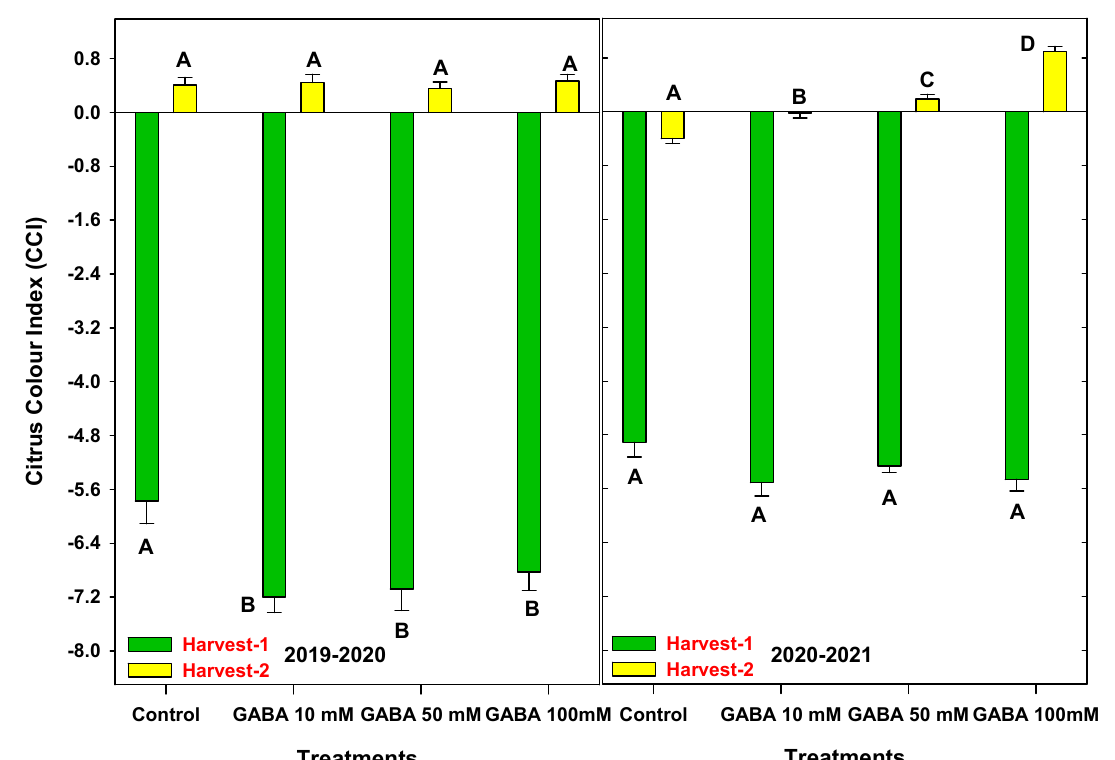
Figure 5. External color (expressed as the citrus color index) of lemons for the two harvest dates and two seasons as affected by GABA treatment. Data are the mean ± SE. Different letters (A, B, C, and D) on the bars denote significant differences at p < 0.05 among the treatments.